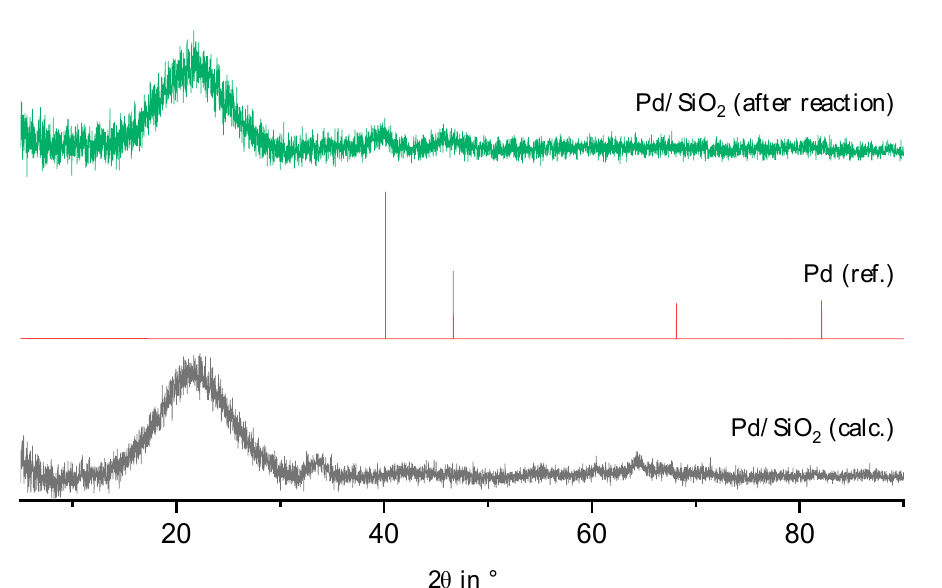
Figure A8. P-XRD of calcined palladium catalyst before reaction (calc.) and after reaction.